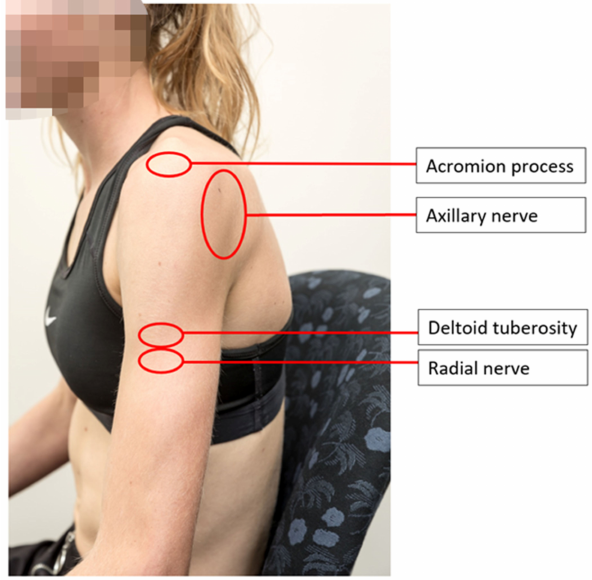
Figure 6. Locations of anatomical